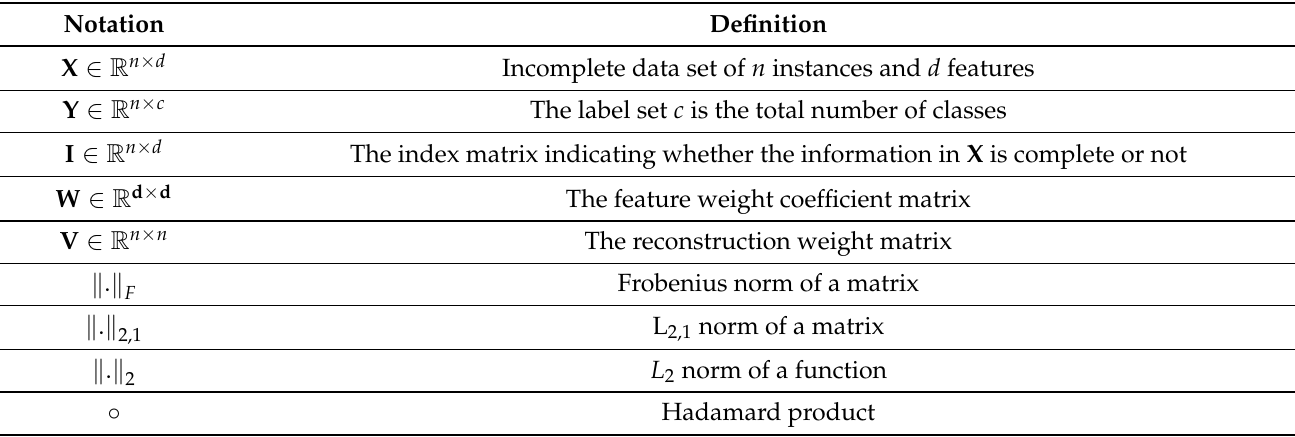
Table 1. The notations used in this